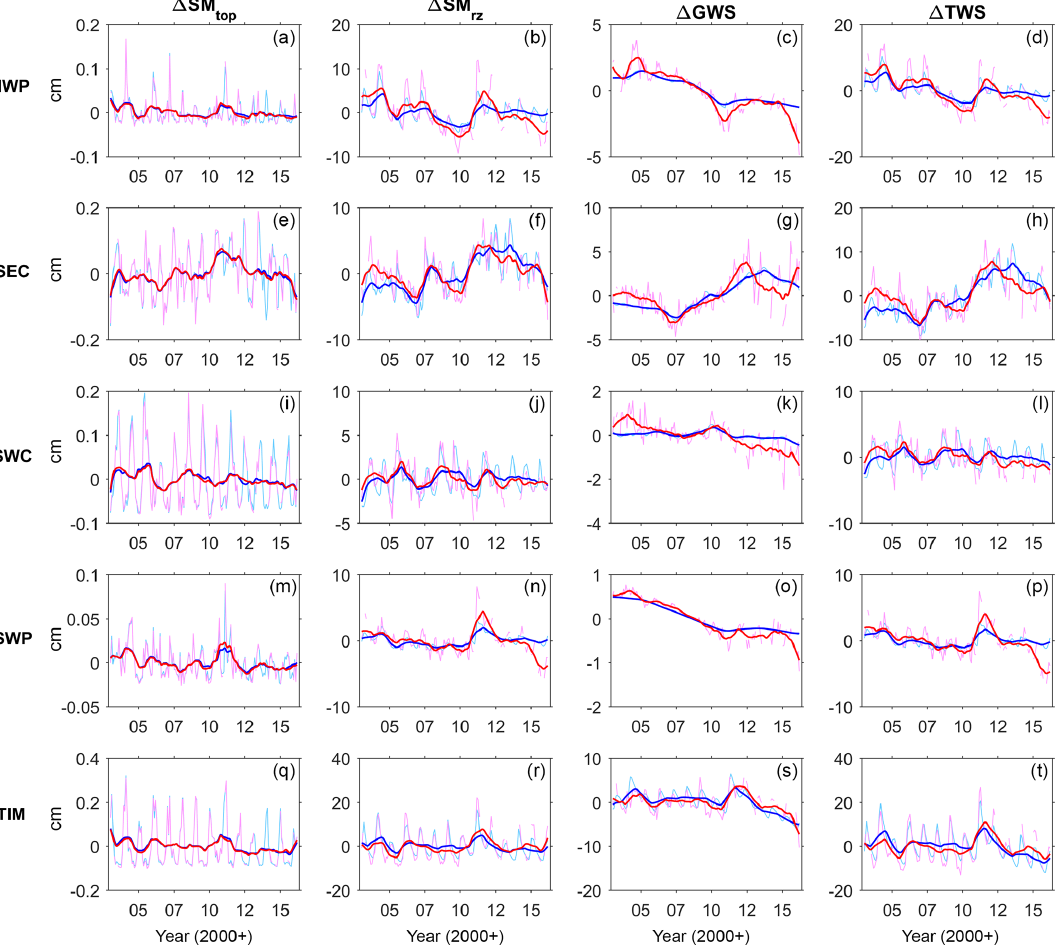
Figure 5. Similar to Fig. 3, but estimated over the North West Plateau (NWP), South East Coast (SEC), South West Coast (SWC), South West Plateau (SWP), and Timor Sea